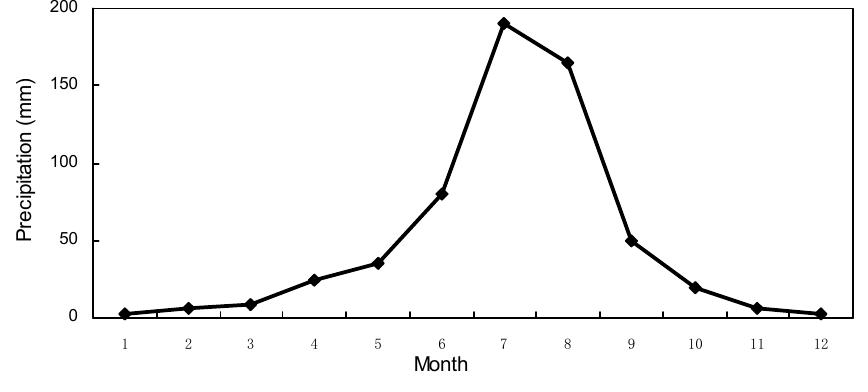
Figure 3. Average precipitation rate during one year in Beijing (Source: [2]).